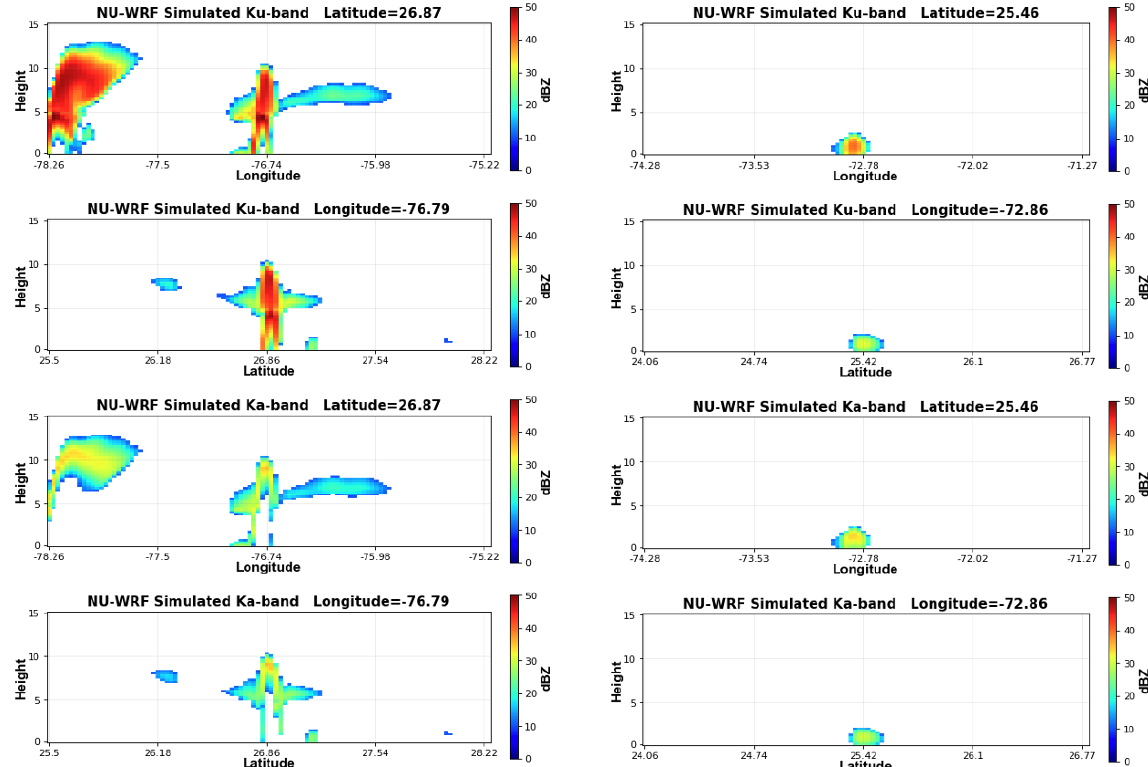
Figure 8. Convection in the 20:00UTC analysis. The left column shows NU-WRF simulated DPR profiles under the black dashed lines crossing at 26.8 ◦ N, 76.8 ◦ W in the box in Fig. 7. From top to bottom: vertical profile of Ku-band reflectivity under the E–W line (latitude 26.8 ◦ N), Ku band under the N–S line (longitude 76.8 ◦ W), and these same two again but for the Ka-band simulation. The right column is the same as the left, but for the NU-WRF simulated DPR profiles under the black dashed lines crossing at 25.5 ◦ N, 72.9 ◦ W in the box in Fig. 7.